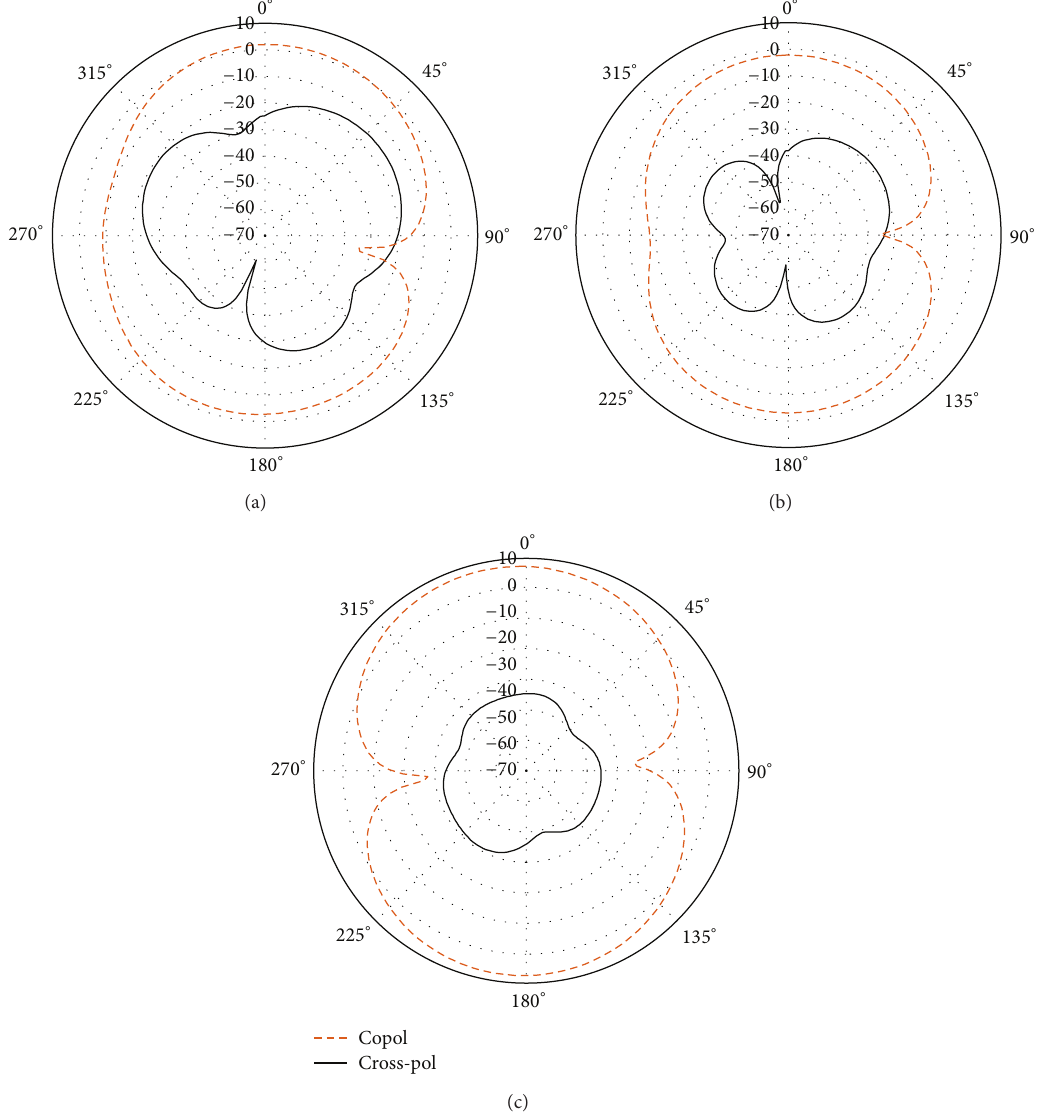
Figure 6: Radiation pattern of the antenna at E-plane for the frequencies (a) 1.85 GHz, (b) 2.27 GHz, and (c) 2.69 GHz.